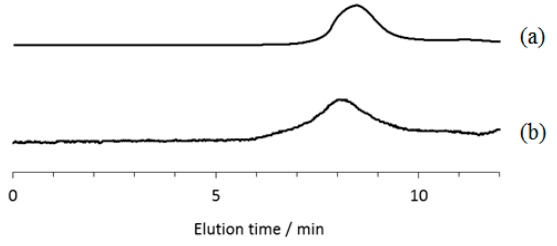
Figure 7. Gel permeation chromatography (GPC) traces of ( a ) ATA–PTHF and ( b ) ATA–PLLA supramolecular polymers.